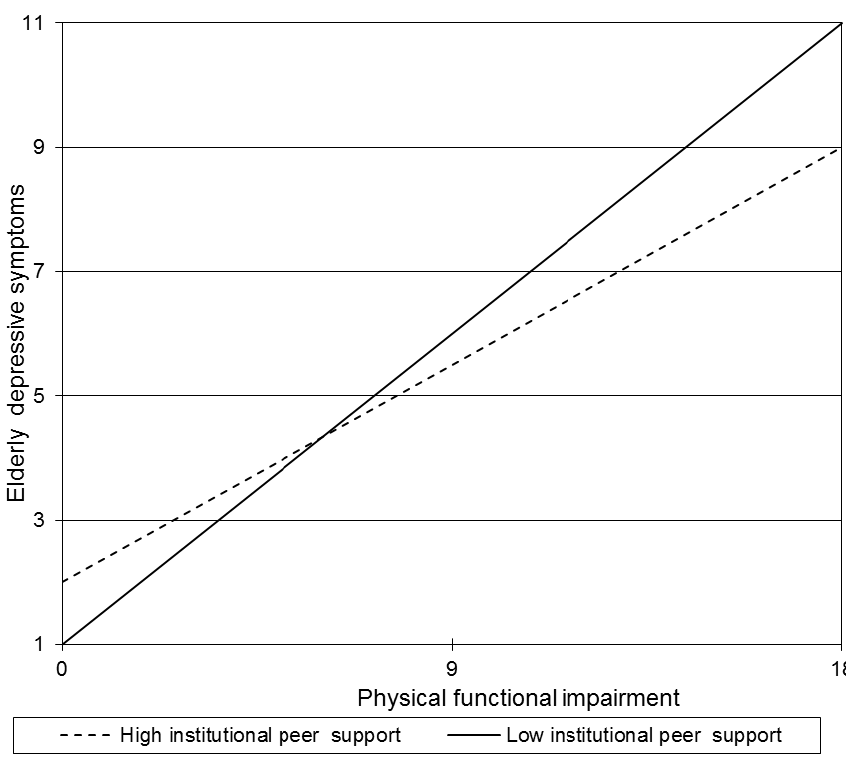
FIGURE 1. Effect of physical functional impairment on elderly depressive symptoms, moderated by perceived institutional peer support